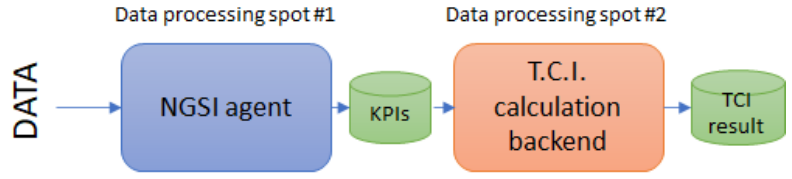
Figure 3. Dual computing approach followed for the proposed framework.